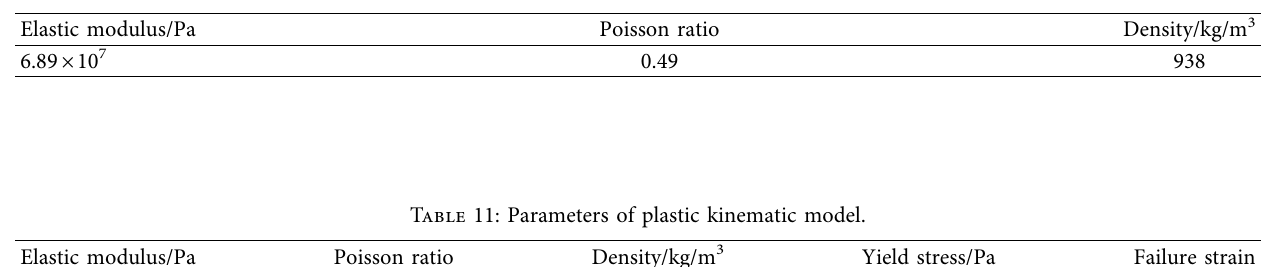
Table 10: Parameters of elastic model.